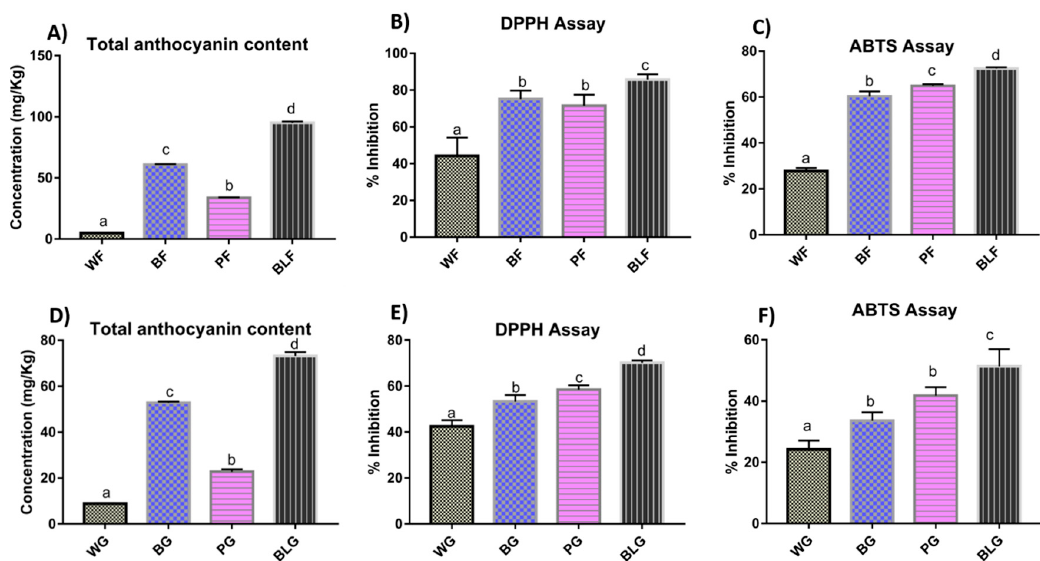
Figure 2. Total anthocyanin content ( A , D ); and antioxidant potential of wheat flour and wheat-grass juice using DPPH (2,2-diphenyl-1-picrylhydrazyl) ( B , E ) and ABTS ((2,2 ′ -azino-bis(3-ethylbenzothiazoline-6-sulfonic acid) ( C , F ) assays. Each bar represents the mean of three replicates ± standard deviation. Significant differences in the bar heights analyzed according to one-way ANOVA. Different letters above bars in each graph represent significantly different values ( p < 0.05) designated with a < b < c. Similar letters above the bars represent values being statistically on par. WF—white wheat flour; BF—blue wheat flour; PF—purple wheat flour; BLF—black wheat flour; WG—white wheat-grass; BG—blue wheat-grass; PG—purple wheat-grass; BLG—black wheat-grass.